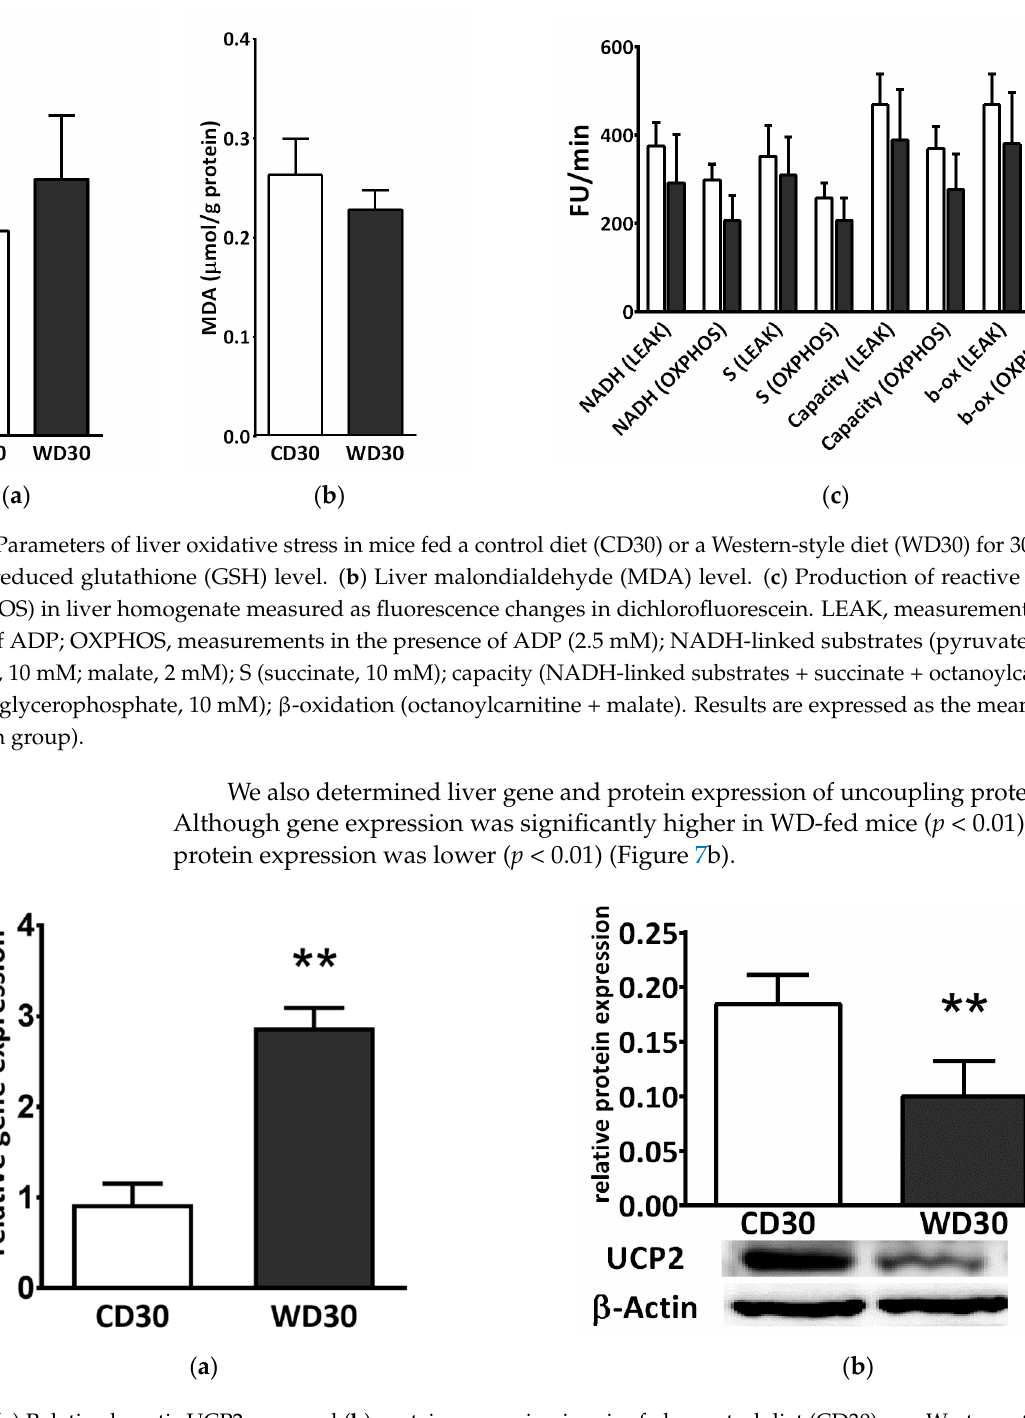
Figure 7. ( a ) Relative hepatic UCP2 gene and ( b ) protein expression in mice fed a control diet (CD30) or a Western ‐ style diet (WD30) for 30 weeks. Results are expressed as the means ± SD; ** p < 0.01 (n = 6 each group).